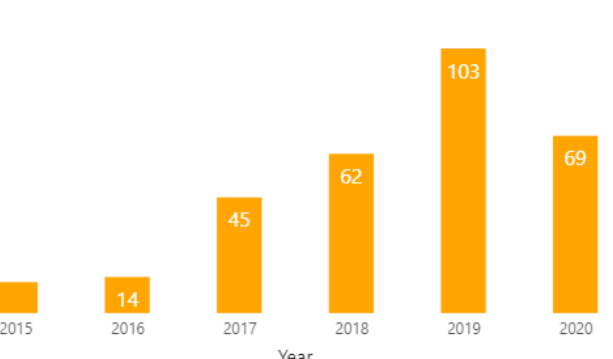
Figure 6. Yearly number of drone intrusions in Italian airports (2015–2020).